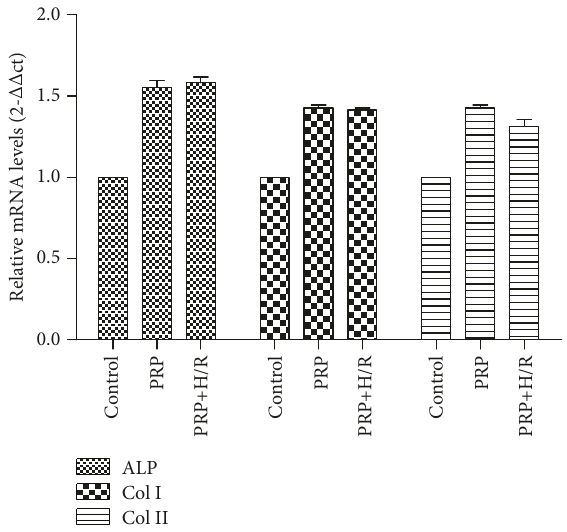
Figure 2: Expression of ALP, Col I, and Col II in BMSCs after H/R treatment.